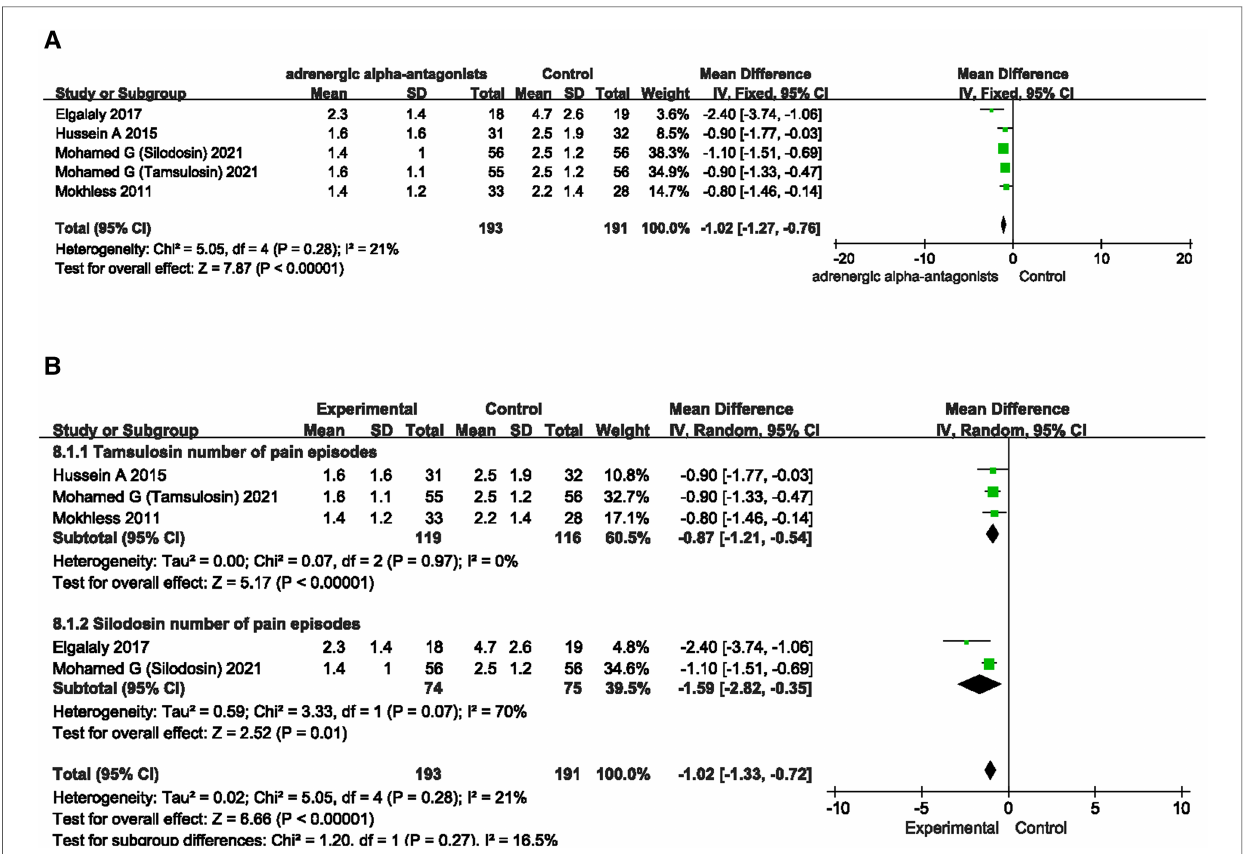
FIGURE 6 Forest plot comparing changes in number of pain episodes between adrenergic 443 alpha-antagonists and control groups. ( A ) Effects of treatment with adrenergic 444 alpha-antagonists on number of pain episodes compared with control group. ( B ) Subgroup 445 analysis of the effects of adrenergic alpha-antagonists on the number of pain